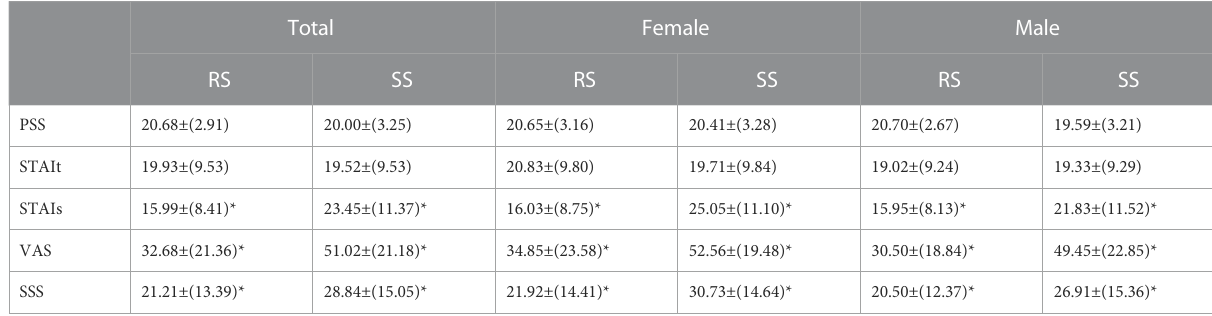
TABLE 3 Psychometric test results.